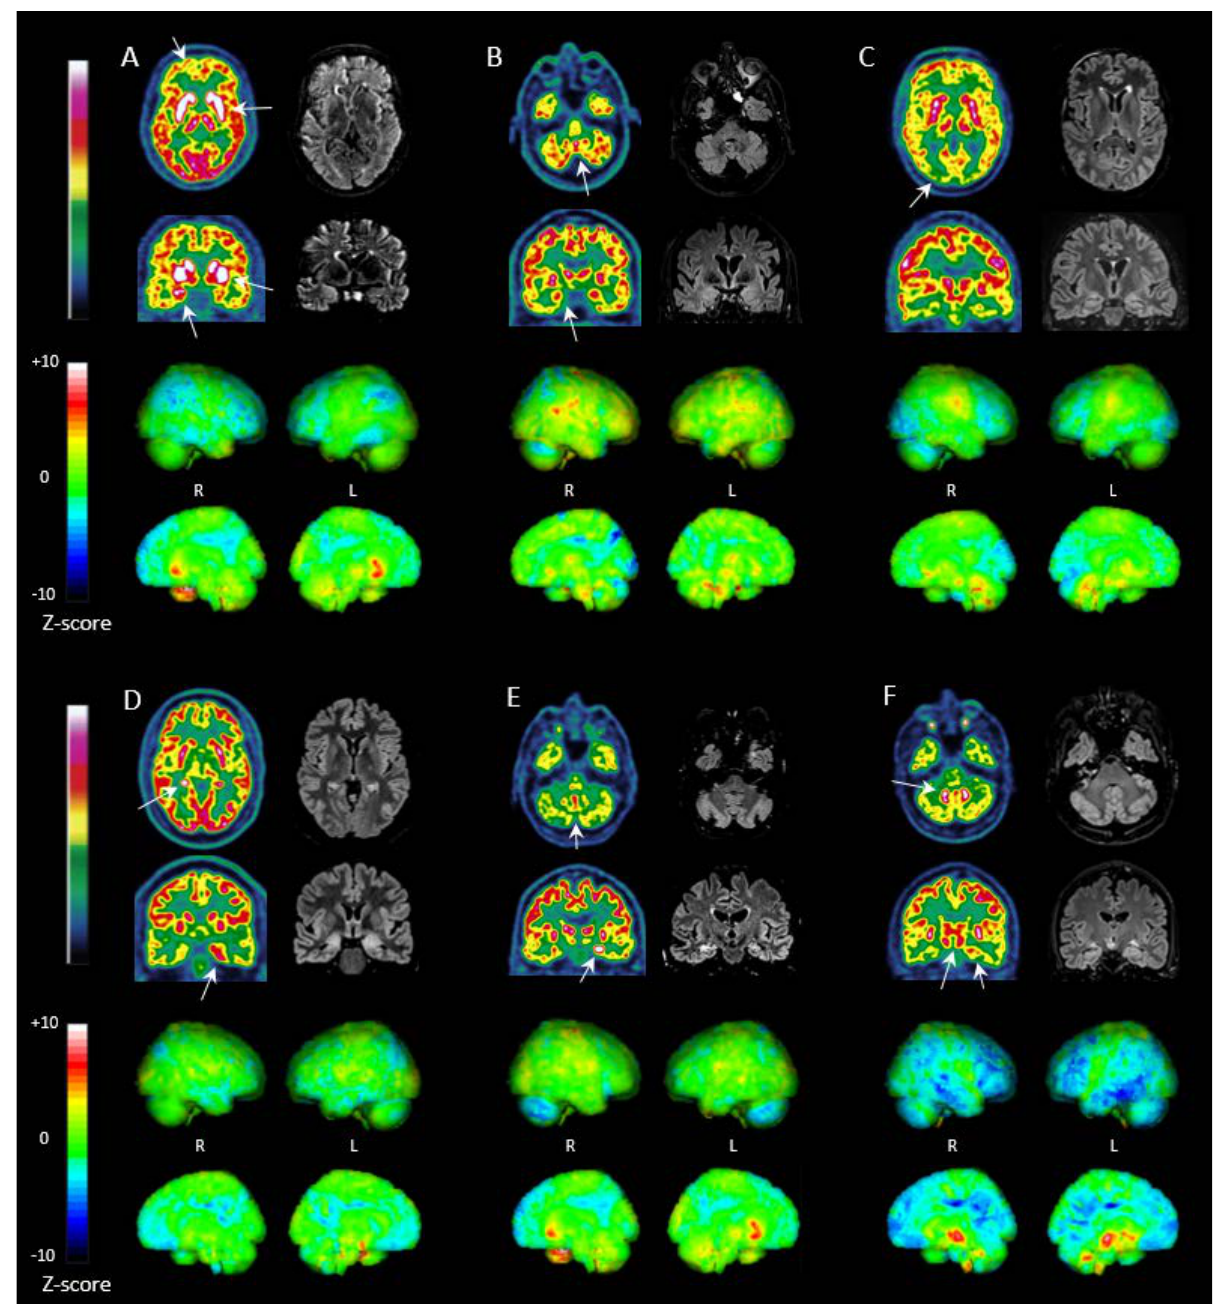
Figure 1. Examples of brain FDG PET and MRI FLAIR images in different AE subtypes. Upper rows: Axial and coronal sections of FDG PET (left) and FLAIR sequence of MRI (right) in patients with AE (white arrows indicate the main metabolic abnormalities). Lower rows: PET quantification (individ- ual Z-score map relative to healthy age-matched controls) displayed as 3D statistical surface projec- tions, lateral views (top) and medial views (bottom). ( A ) LGI1 AE with severe striatum hyperme- tabolism, bilateral MTL hypermetabolism, and cortical hypometabolism involving the prefrontal cortex on PET, with right MTL FLAIR hyperintensity and swelling on MRI. ( B ) CASPR2 AE with bilateral MTL hypermetabolism and increased vermis and dentate nuclei metabolism on PET, with bilateral MTL FLAIR hyperintensity and swelling on MRI. ( C ) NMDAR AE with severe occipital hypometabolism and moderate diffuse cortical hypometabolism on PET, and normal FLAIR images on MRI. ( D ) GAD AE with bilateral MTL hypermetabolism on PET (including the para-hippocam- pal gyrus and hippocampus), with bilateral MTL FLAIR hyperintensity and swelling on MRI. ( E ) Anti-Hu AE with bilateral MTL hypermetabolism and increased vermis and dentate nuclei metab- olism, contrasting with cerebellar hemisphere hypometabolism on PET. MRI shows bilateral MTL